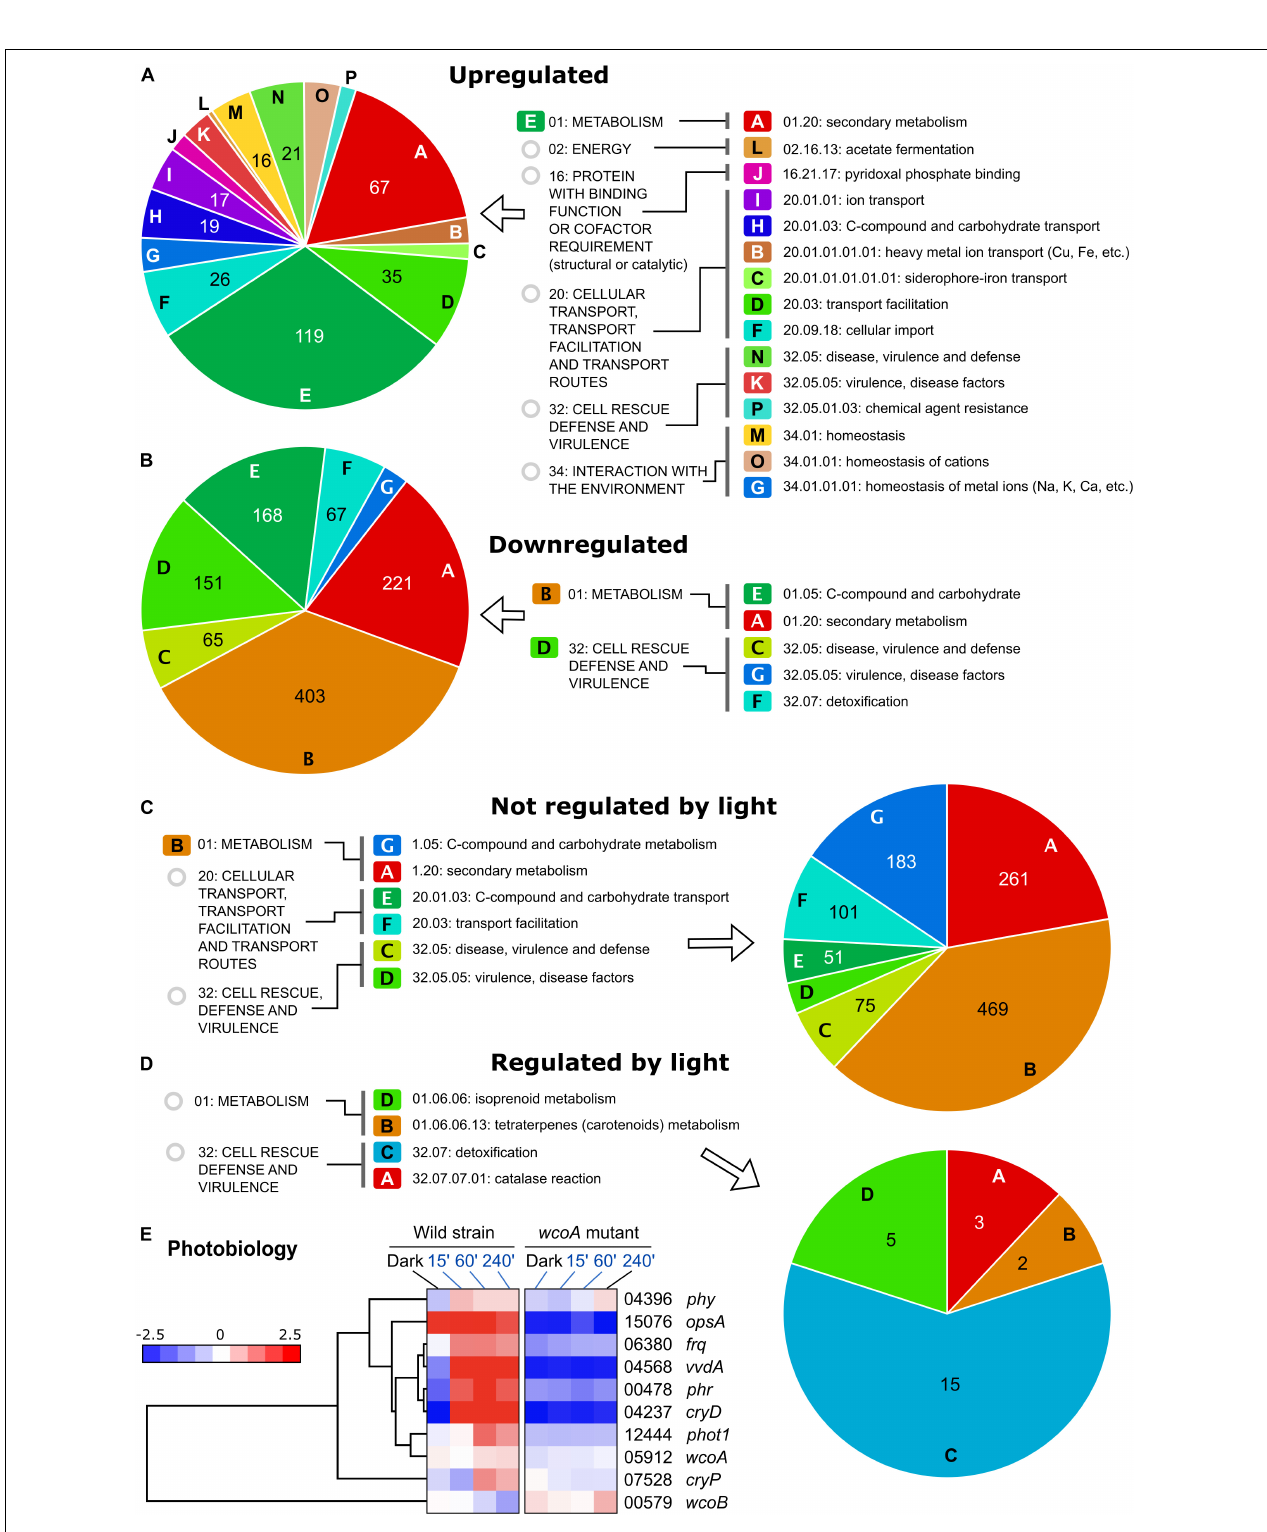
FIGURE 5 | Funcat categories of the genes affected by the wcoA mutation. (A) Categories of genes induced in the wcoA mutant (therefore, downregulated by WcoA). (B) Categories of genes repressed in the wcoA mutant (therefore, upregulated by WcoA). (C) Categories of genes not regulated by light in the wild strain whose transcripts changed in the wcoA mutant. (D) Categories of genes regulated by light in the wild strain whose transcripts changed in the wcoA mutant. (E) Hierarchical heatmaps for the effect of illumination and/or the wcoA mutation on the mRNA levels of genes related to F. fujikuroi photobiology. FFC1_ numbers of the genes, and names given in the literature, are indicated on the